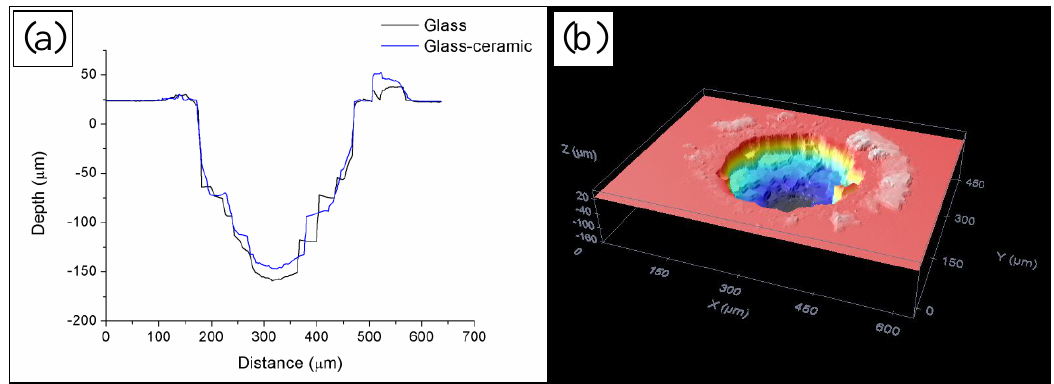
Figure 1. Profile of the machined depth obtained in a 300 µm diameter laser ablated crater at a reference position of −2 mm out of focus ( a ), and topography of the surface of the machined area ( b ).